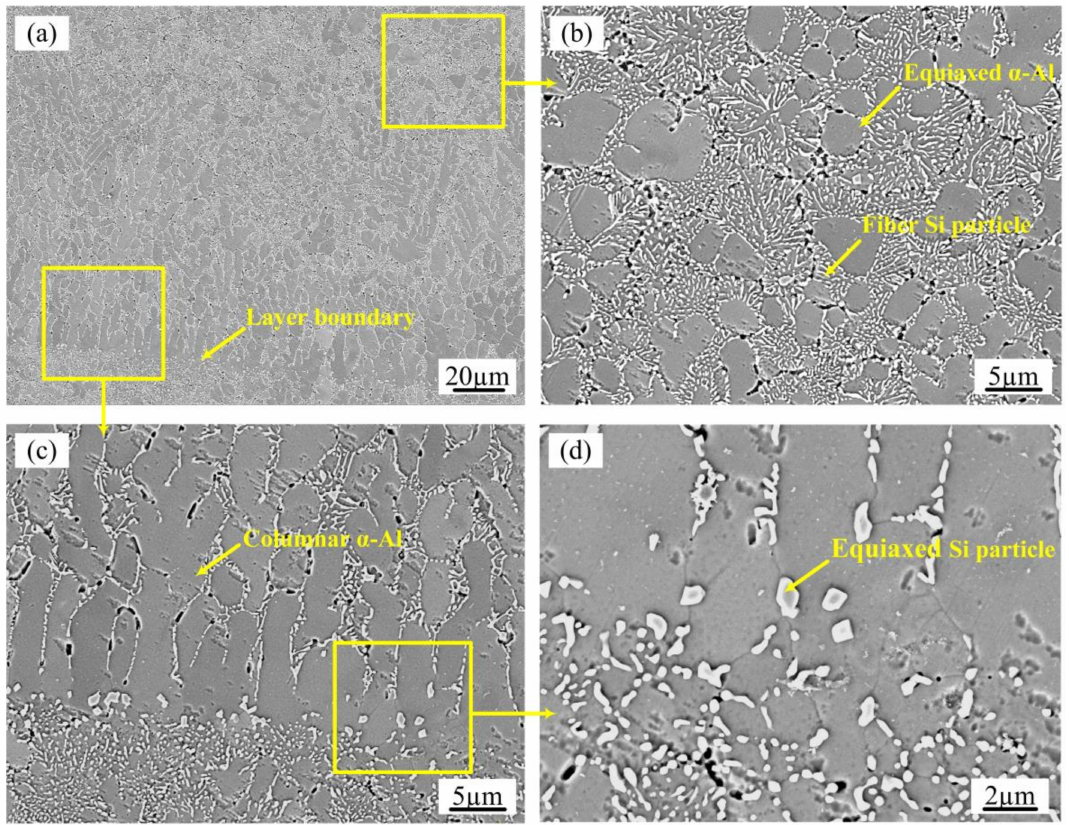
Figure 7. SEM microstructures showing the morphology of Si at di ff erent locations in the samples produced by UALMD: ( a ) low magnification micrograph of the deposited layer; ( b ) Si in the eutectic structure of the molten pool; and ( c , d ) Si along the layer